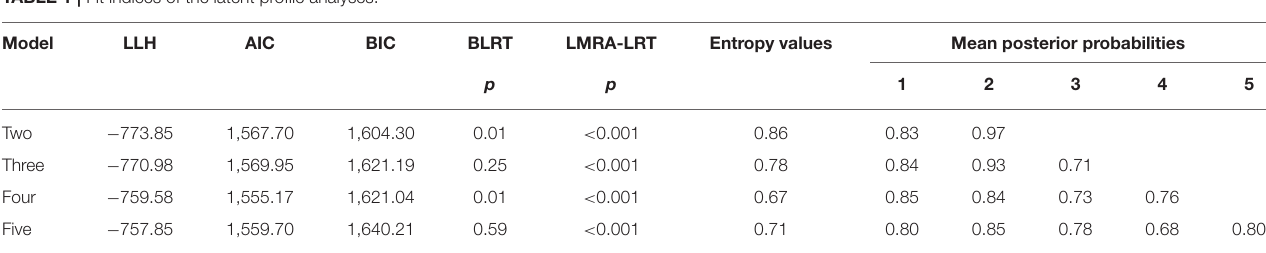
TABLE 1 | Fit indices of the latent profile